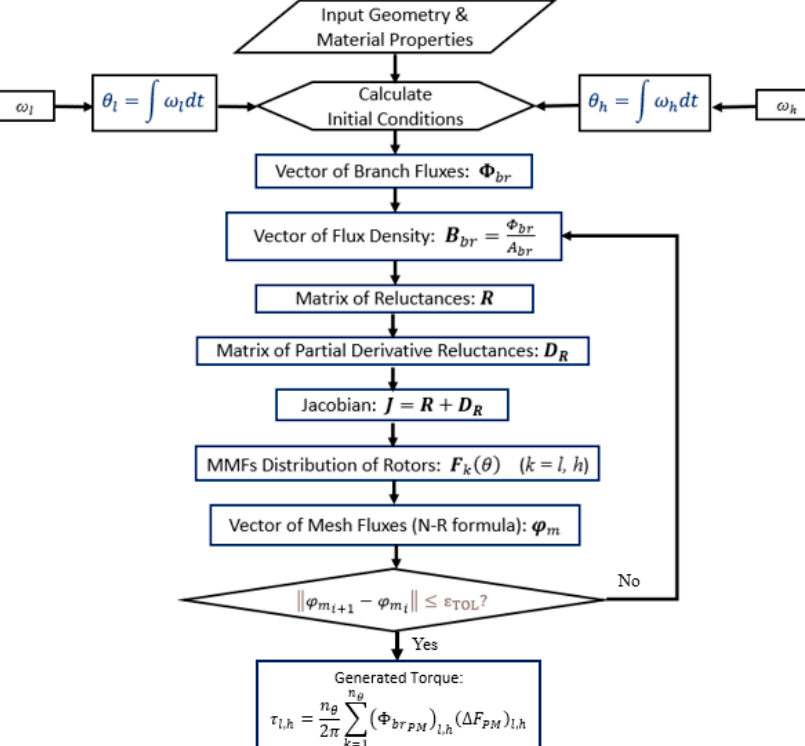
Figure 5. Flowchart of the overall procedure for MEC-RN solution.